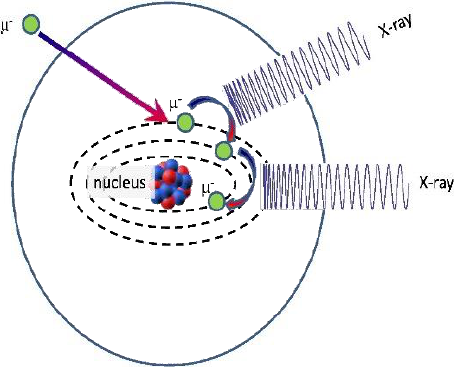
Figure 1. Muonic capture process. The muon then has a finite probability of being captured by the nucleus and may emit a gamma. The figure was taken and adapted with permission from Ref. [7] © 2016, Elsevier Ltd.